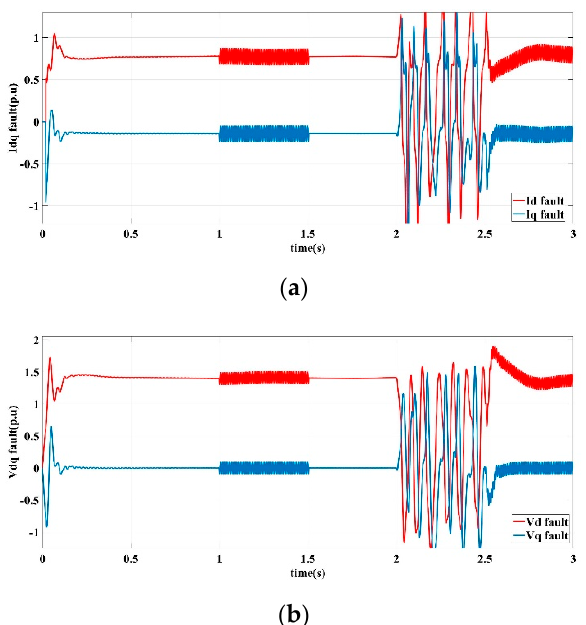
Figure 8. Output feedback control response curves in scenario III. ( a ) d -axis and q -axis current output, ( b ) d -axis and q -axis voltage output.